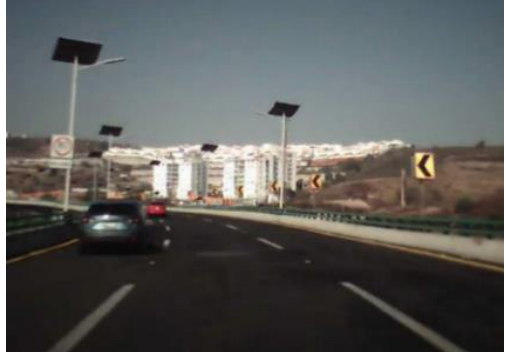
Figure 4. Original imagen taken at the “Viaducto Bicentenario” of the State of Mexico.